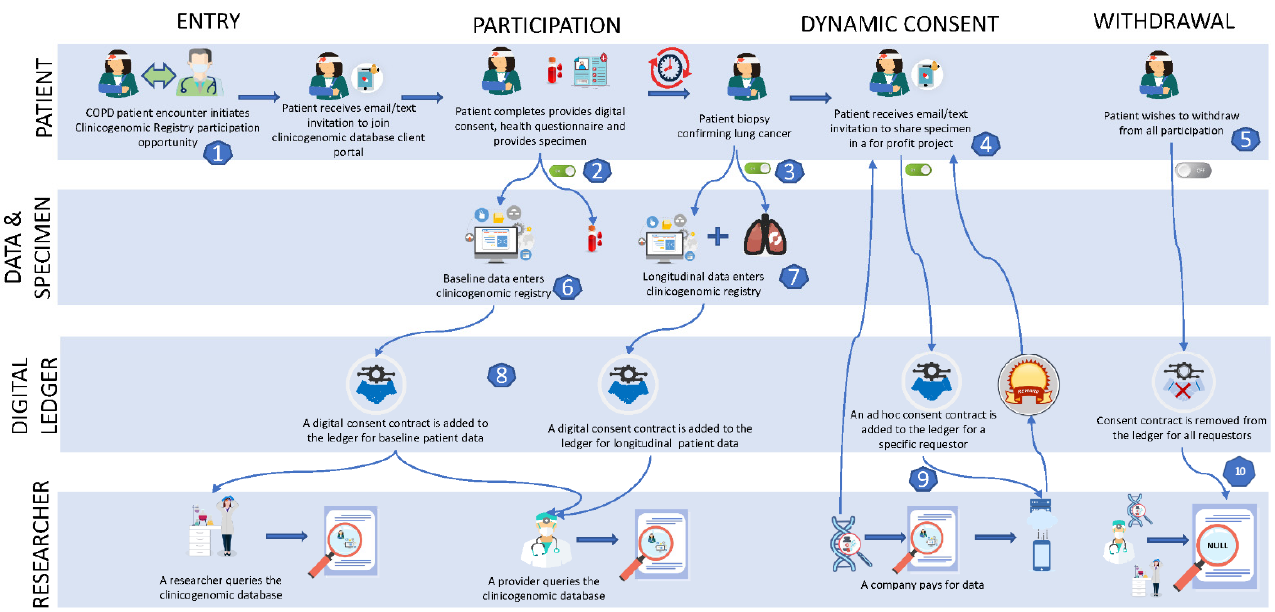
Figure 1. Schematic diagram of the patient and data journey in an idealized clinicogenomic database administered on a digital-blockchain ledger.